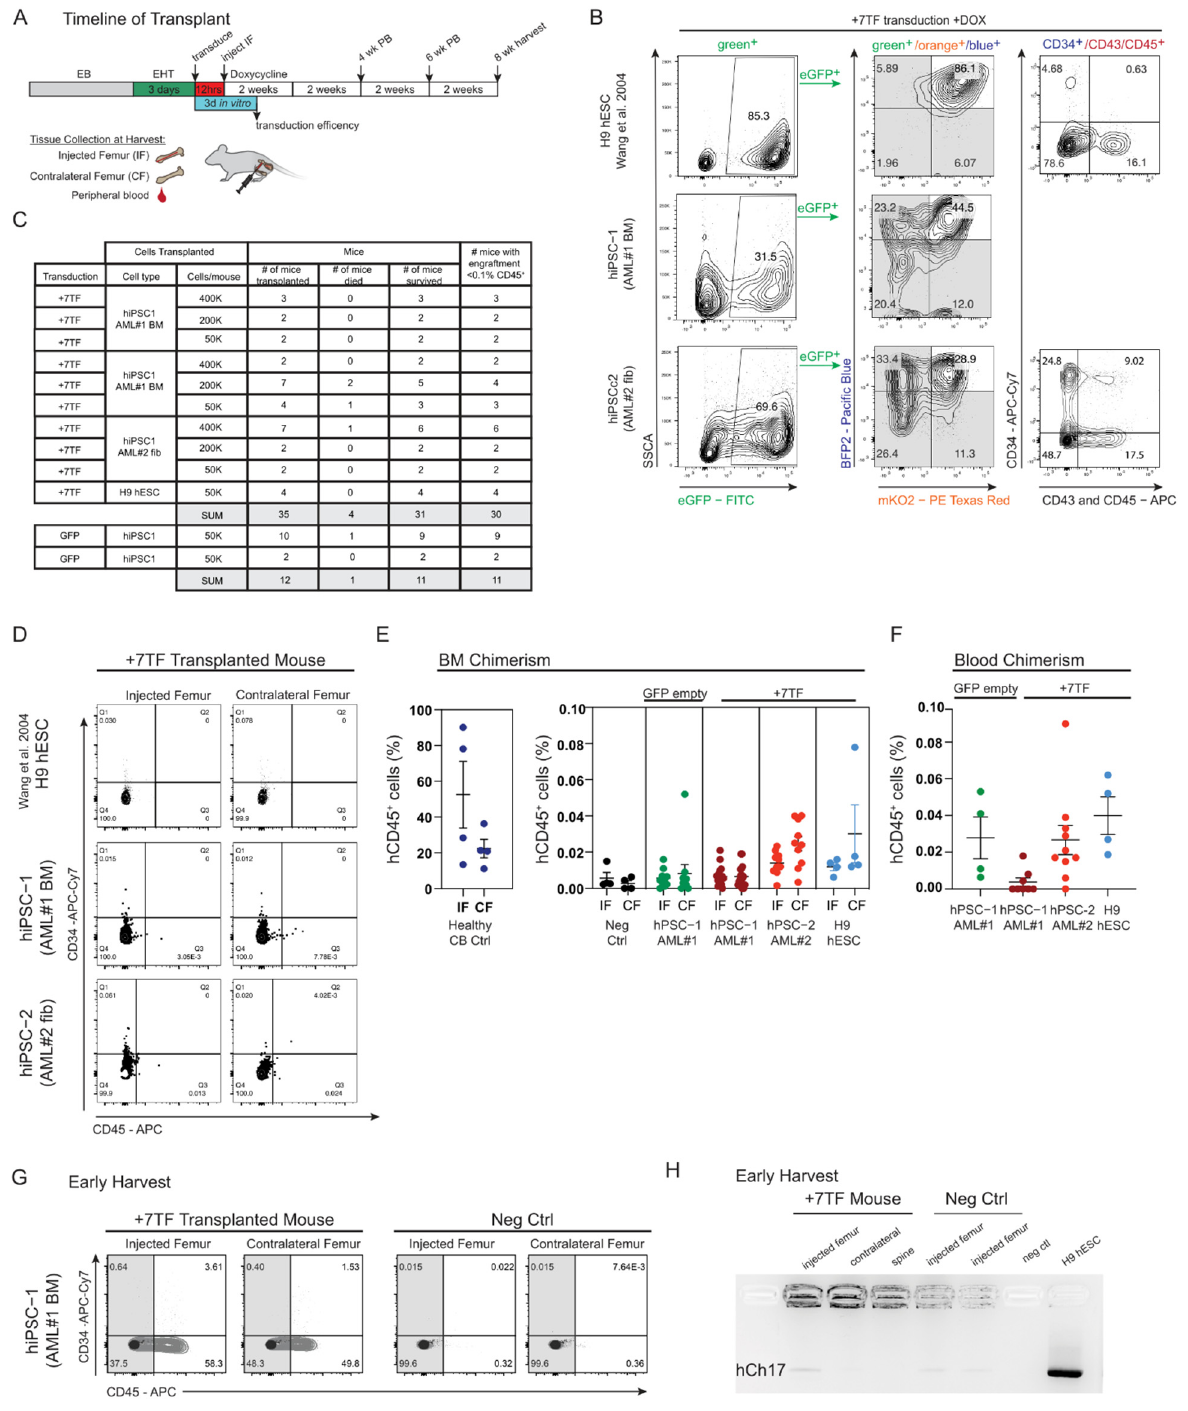
Figure 5. Early harvest of transplanted mouse reveals human hematopoietic chimerism. ( A ) Schematic depicting timeline of transplantation experiments. Hemogenic endothelium cells infected at day 3 EHT were incubated for 24 h and intrafemorally (IF) injected into mice. Doxycycline was provided for 2 weeks in vivo after transplantation into sub-lethally irradiated immune-deficient NSG mice. Three days post-transfection, transduction efficiency of transplanted cells were assessed. Tissues collected during each harvest was as follows: injected femur, contralateral femur, and peripheral blood via cheek bleeds. ( B ) Representative transduction efficiency flow plots of fluorescent proteins multiplexed by flow cytometry. Doxycycline induction of 7 TF-transduced hemogenic endothelium, maintained in vitro 6 days beyond the day of transplant. Acquisition of hematopoietic